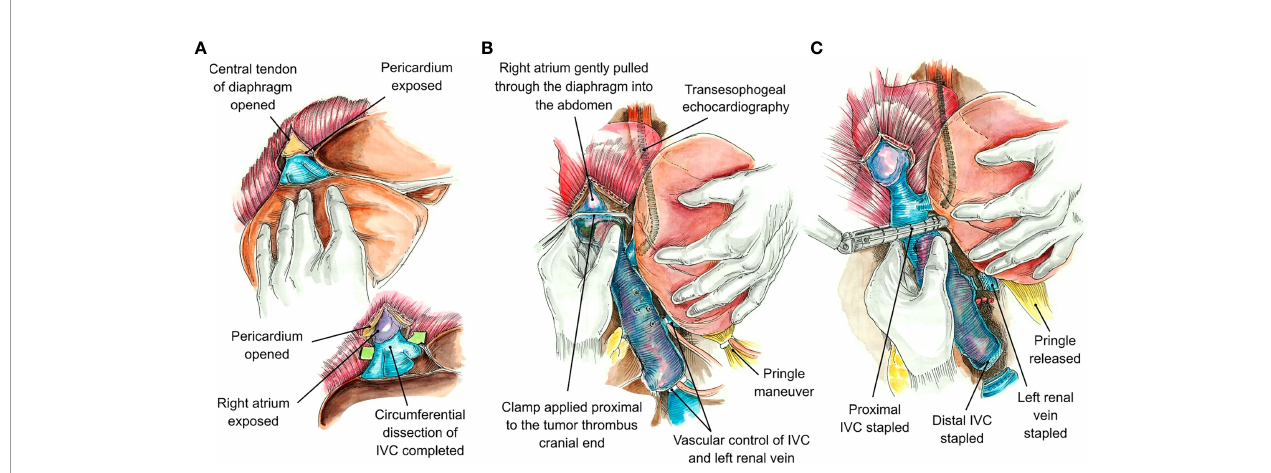
FIGURE 2 | Tumor thrombus (TT) removal avoiding the use of cardiopulmonary bypass (CPB). The central tendon of the diaphragm is opened vertically, and the pericardium is exposed. If more exposure is required, the pericardium may also be opened. Circumferential control of the inferior vena cava (IVC) at a suprahepatic level facilitates TT removal (A) . The right atrium may be pulled downward through the diaphragm and into the abdomen, and the cranial end of the TT was controlled under Pringle maneuver conditions by cross-clamping the IVC above this level. Simultaneous transesophogeal echocardiography provides visual guidance during the performance of these maneuvers (B) . When the tumor thrombus can be milked down distal to the major hepatic vein ori fi ces, an endo-GIA stapler may be utilized to staple the IVC proximally. Once the IVC is stapled, the liver vascular fl ow can be reestablished by releasing the Pringle maneuver. The procedure is completed by stapling the IVC distally and the left renal vein close to its entrance in the vena cava (C)